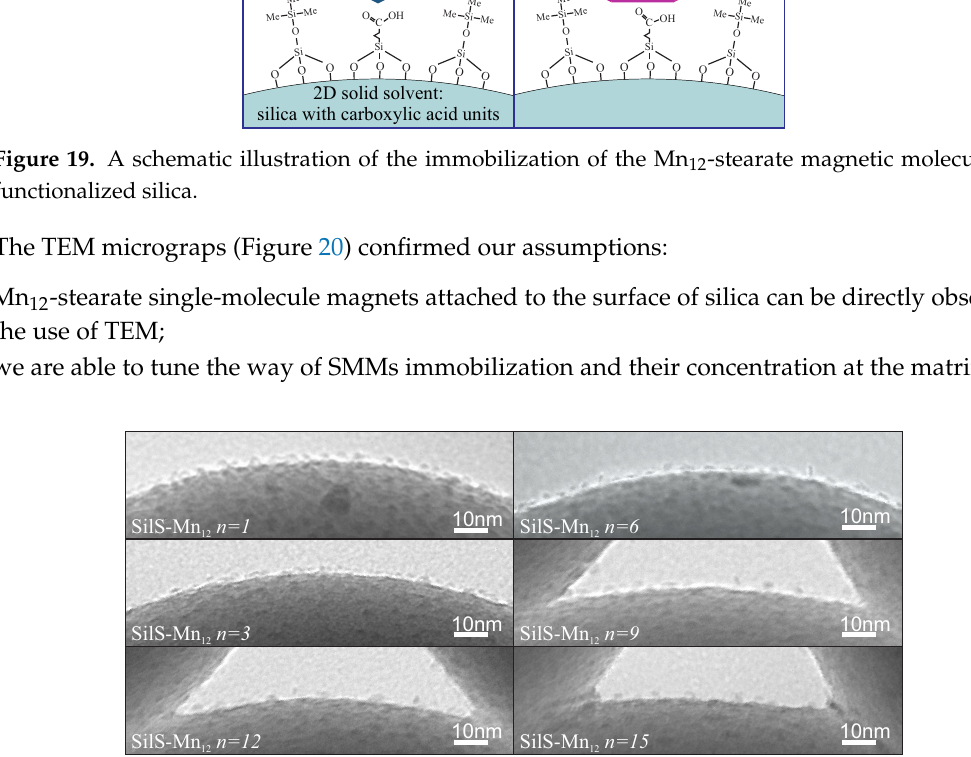
Figure 20. TEM micrographs of the Mn 12 -stearate molecules attached to the spherical silica-based materials containing various concentrations of the anchoring units separated by spacer groups. The n denotes the number of spacer units per single anchoring